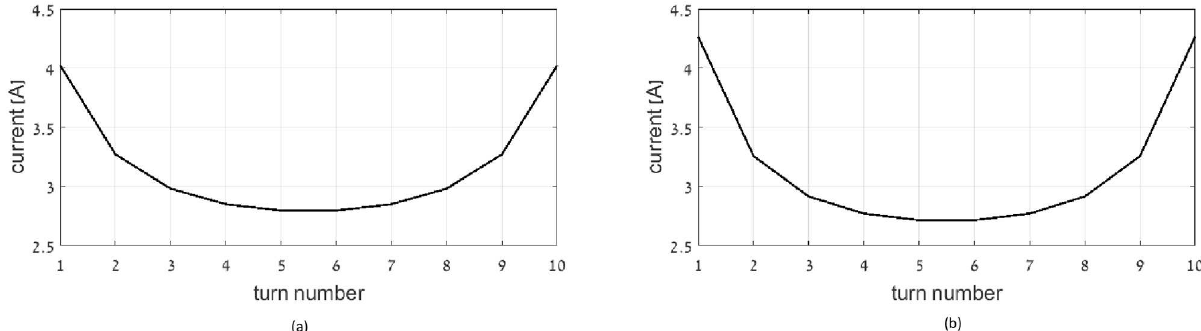
Fig 10. Current distribution in optimal single-layer solenoid coil: wire radius: (a) 0.1 mm, (b) 0.5 mm.